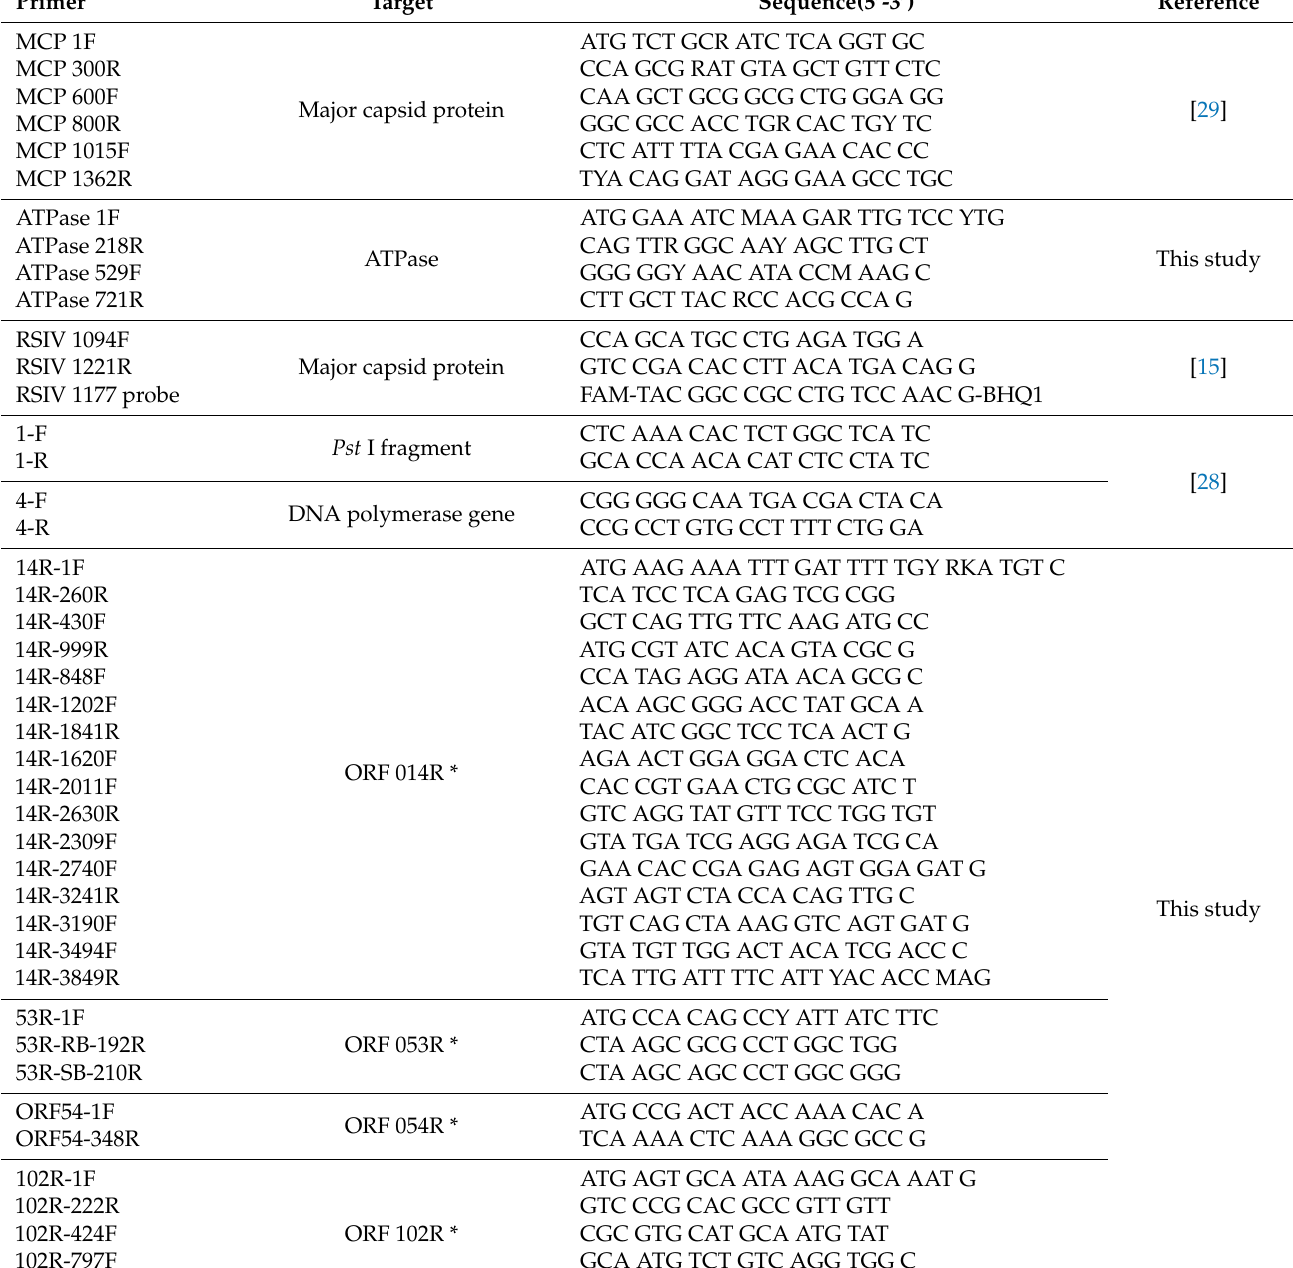
Table A1. PCR primers used in this